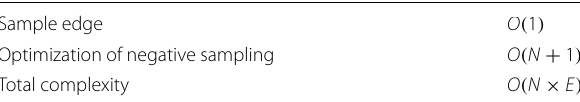
Table 3 Net Complexity of